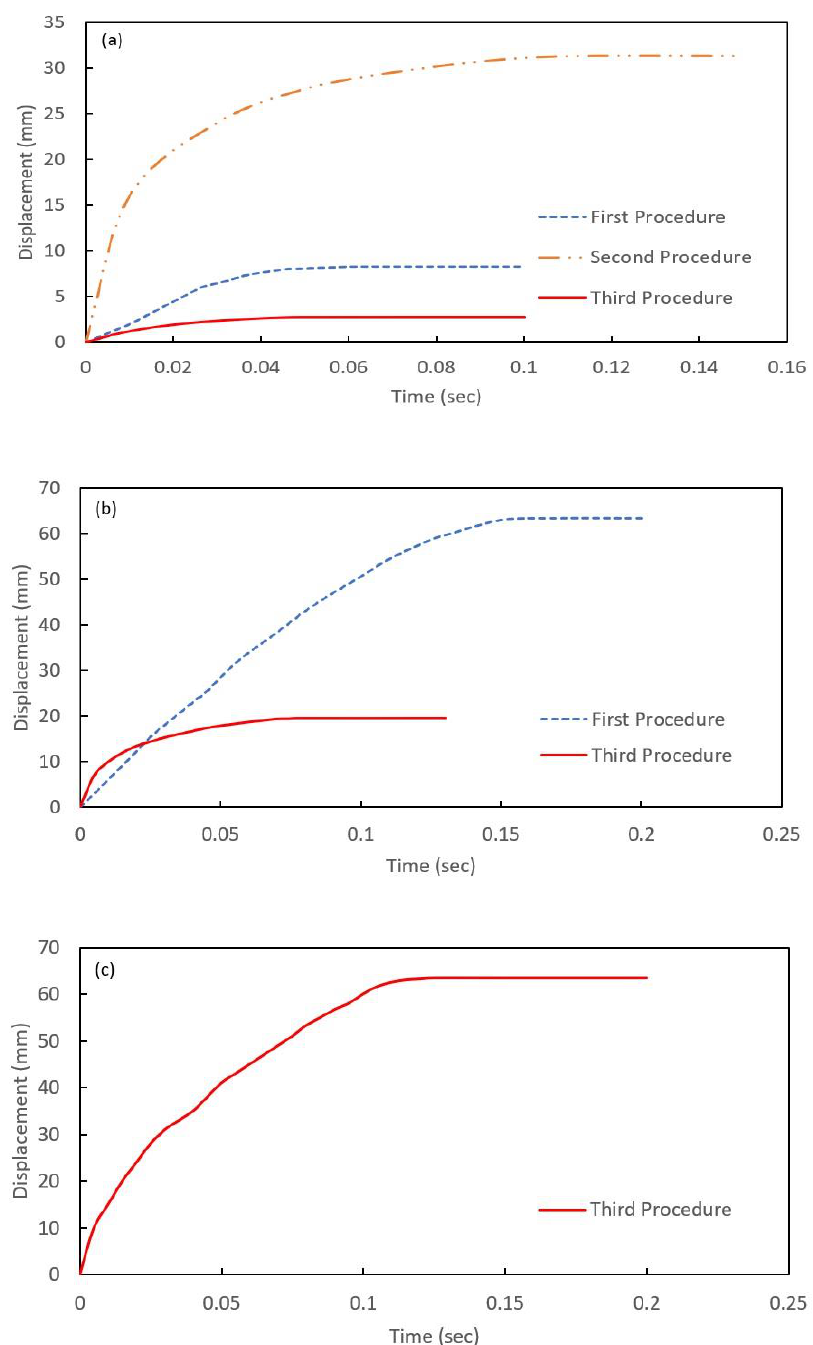
Figure 6. The dynamic response of the flexible two - finger hand with an applied load of ( a ) 1.5 N, ( b ) 2.5 N, and ( c ) 3.5 N, showing control procedures that were able to achieve stable